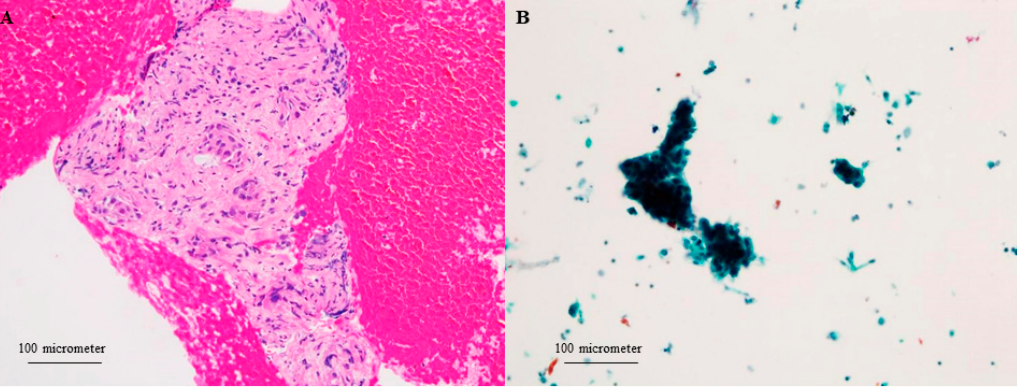
Figure 2. Scanned magnification (200×) image of hematoxylin-eosin staining ( A ) and liquid-based cytology ( B ) using a 22-gauge needle for pancreatic adenocarcinoma.